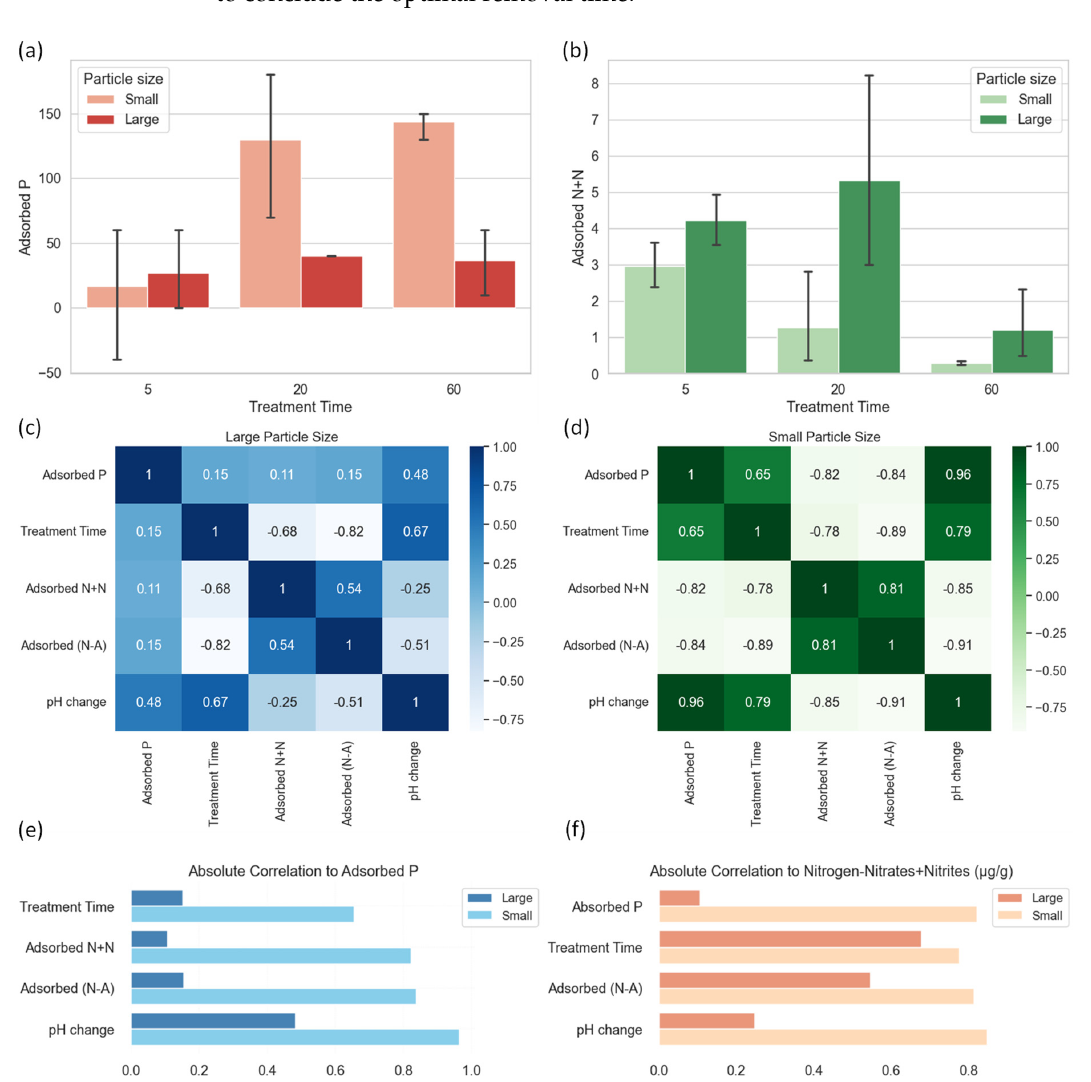
Figure 6. Analyses of field experiment results: Nitrate-N + Nitrite-N (N+N); Nitrogen-Ammonium (N-A); ( a ) adsorption of P and ( b ) adsorption of N+N over the treatment times and particle size; matrix of the Pearson correlation coefficient between each variable for ( c ) large particle and ( d ) small particle biomaterial adsorption trend of P and N+N, respectively; ( e ) absolute values of Pearson coefficients related to P adsorption; and ( f ) absolute values of Pearson coefficients related to N+N adsorption ( fi gure generated by Python programming language).